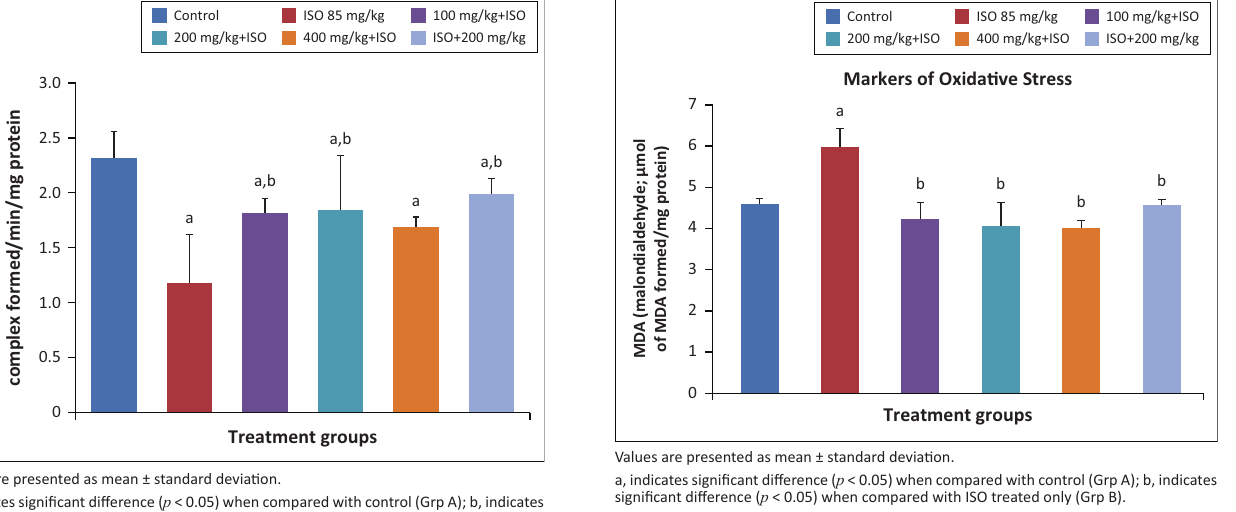
FIGURE 8: Effect of the ethanolic extract of Andrographis paniculata on lipid peroxidation in isoproterenol-induced myocardial infarction using rats as a model ( n = 5).